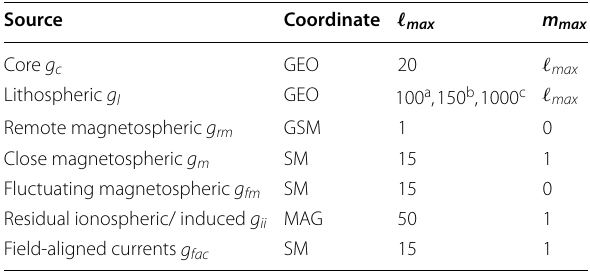
Table 2 Magnetic sources considered in the model (first column) together with the coordinate systems they are expressed in (second column)